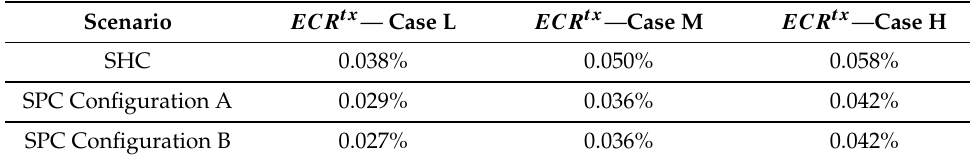
Table 11. Average 𝐸𝐶𝑅 𝑡𝑥 under different traffic